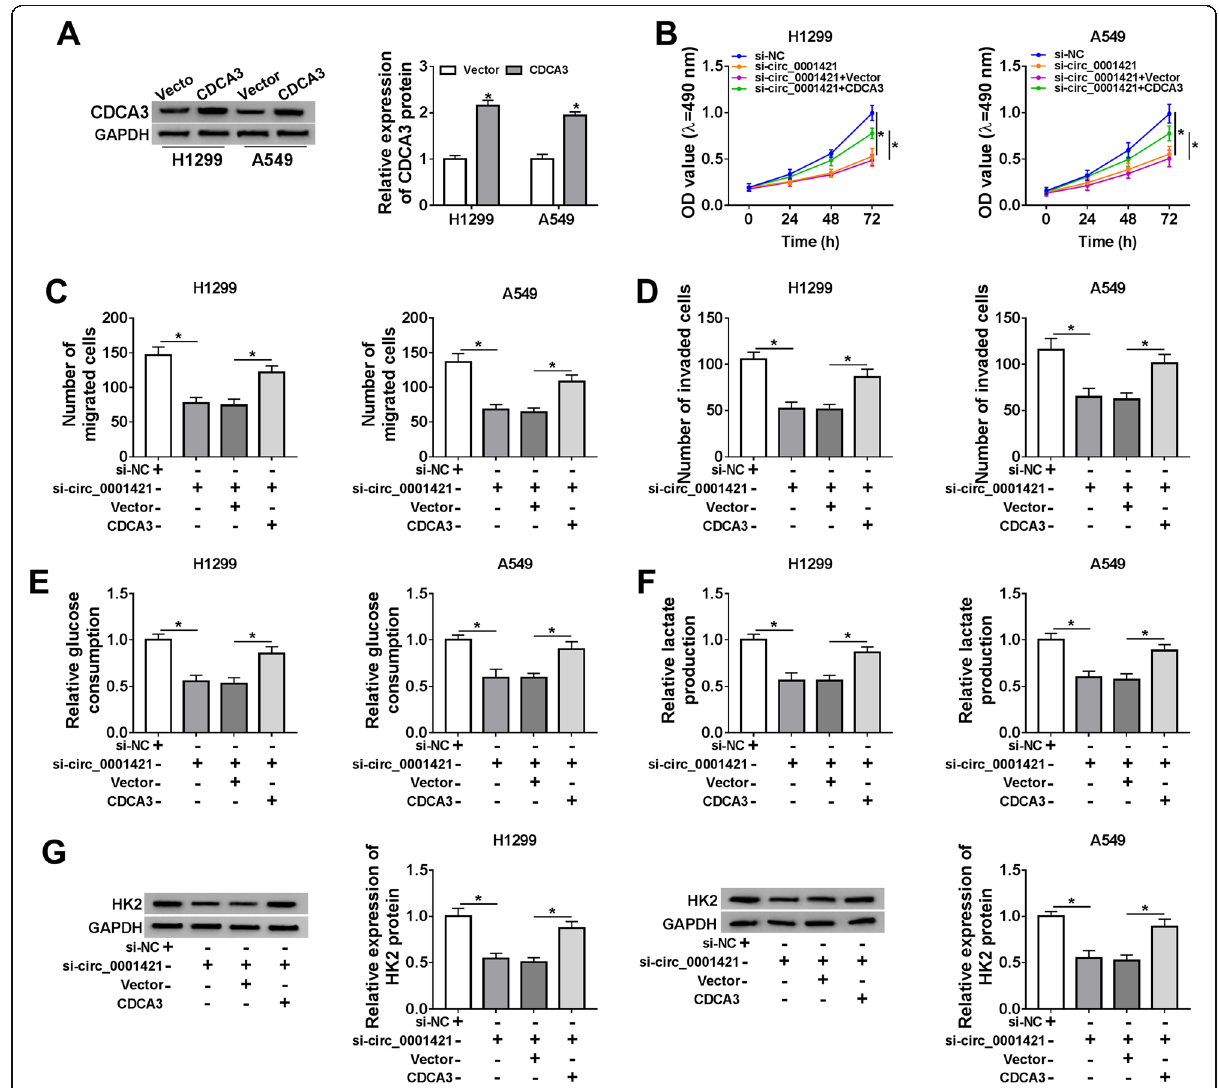
Fig. 6 CDCA3 overexpression reversed the inhibitory effects of circ_0001421 knockdown on LC cell proliferation, migration, invasion and glycolysis. a The protein of CDCA3 in H1299 and A549 cells transfected with Vector or CDCA3 was detected by western blot. b-g H1299